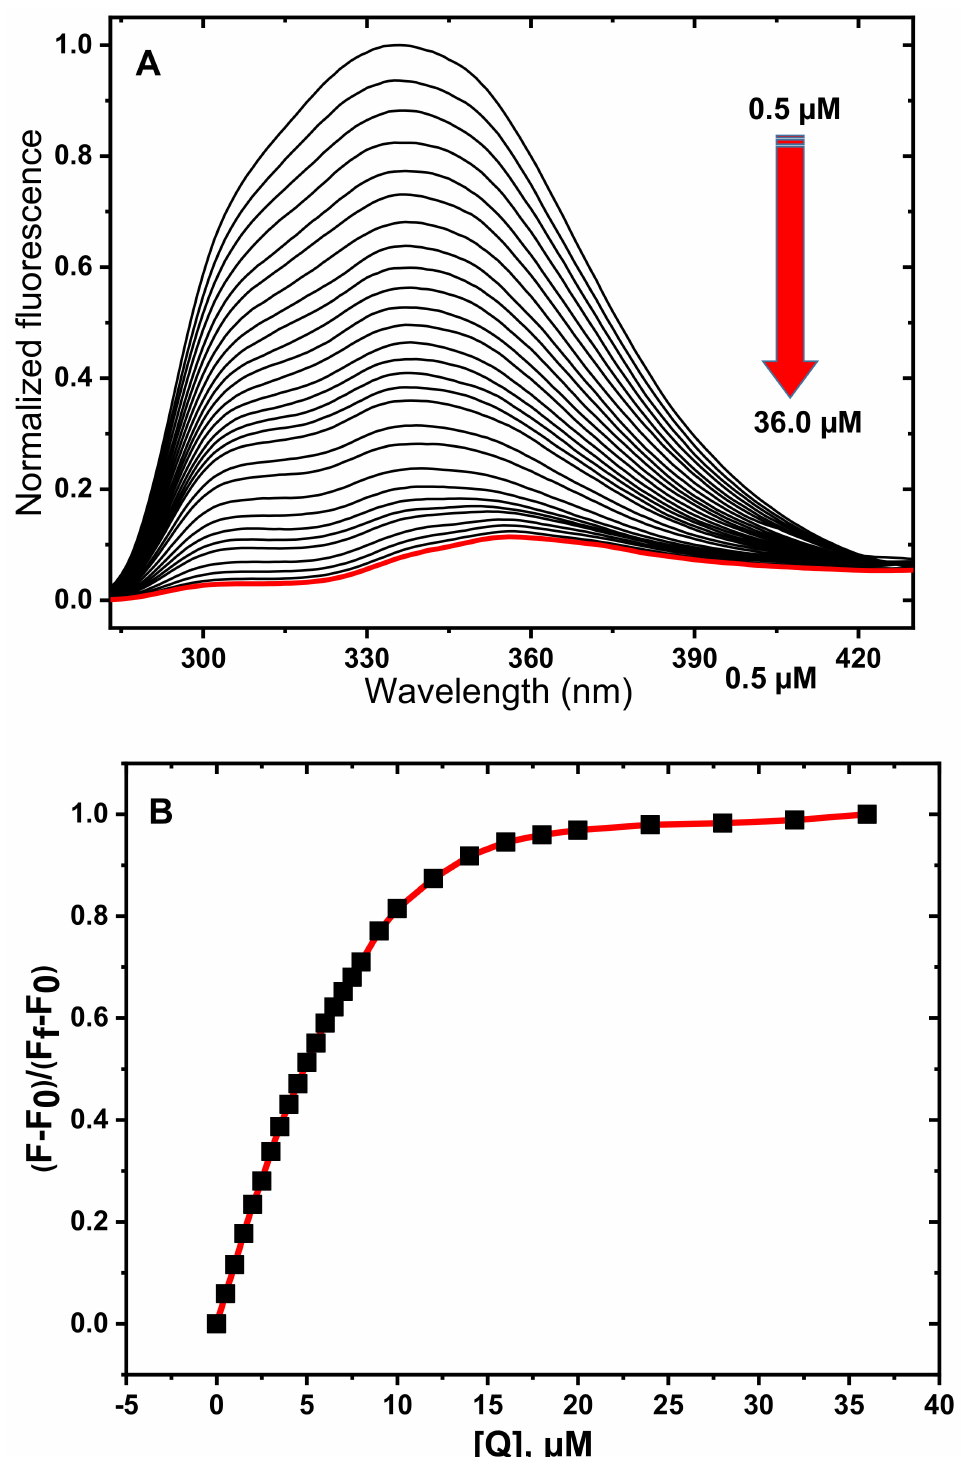
Figure 4. ( A ) Fluorescence spectra of 20.0 µ M human serum albumin (HSA) in the presence of PAZ with concentrations varying from 0.5 µ M to 36.0 µ M at pH 7.4 and 310.15 K. ( B ) Corresponding binding isotherm and fitting curve (F 0 : initial fluorescence intensity, F f : final fluorescence